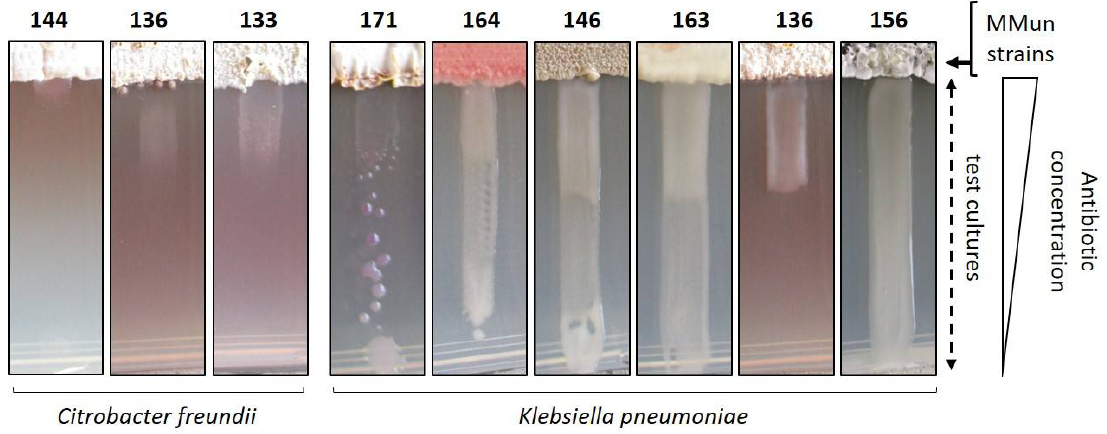
Figure 9. Illustration of the paradoxical zone phenomenon (or Eagle effect) observed with Klebsiella pneumonia and Citrobacter freundii . MMun156 was chosen as a control to show non-affected growth of K. pneumoniae on the ISP7 medium. All conditions where an Eagle effect was observed are marked with a “star” symbol in Figure 6.